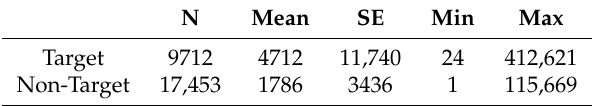
Table 6. FOX statistics on the cascade size. KS-test for target and non-targets: D = 0.066, p ≈ 0.0.